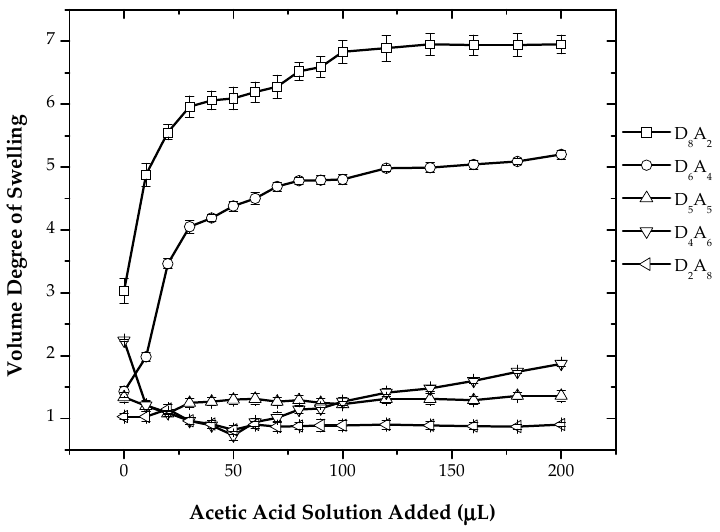
Figure 5. Variation of the volume degree of swelling with the addition of acetic acid for System II.